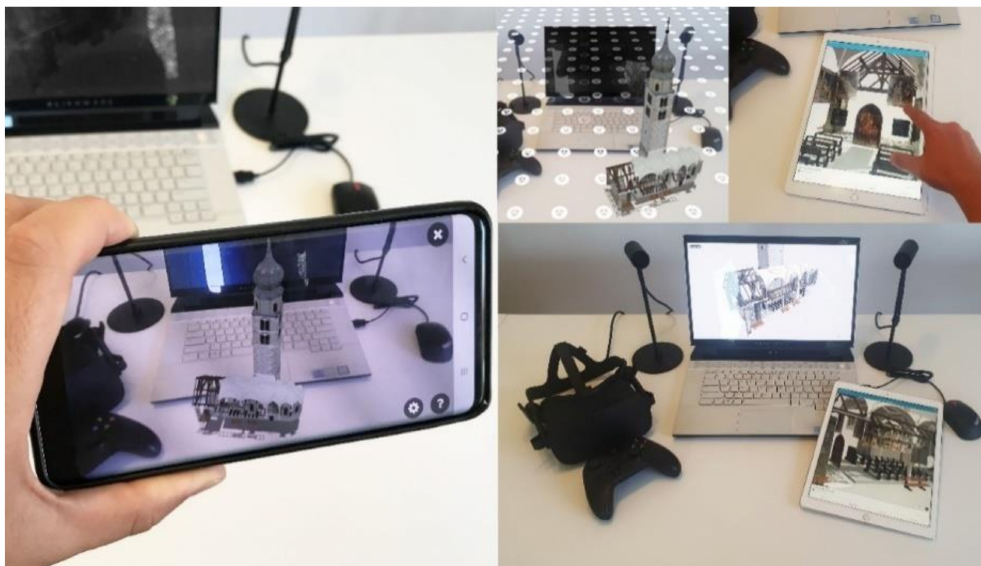
Figure 13. AR objects developed for a web-based AR platform: user can interact with IVOs and discover different information related to the frescos, painting, decorative apparatus, and architectural and structural element of the church without going directly to the